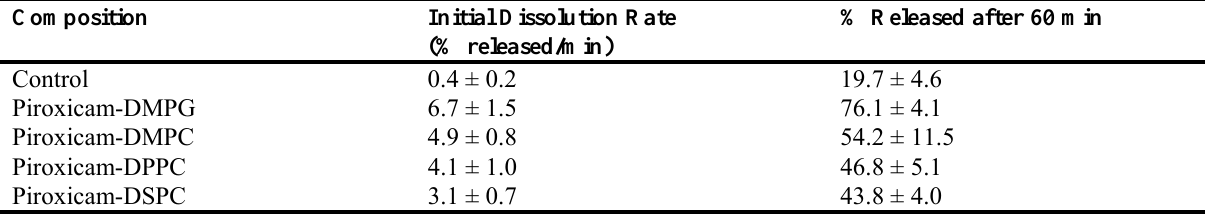
Table 1. Dissolution characteristics of different solid dispersions of piroxicam (drug